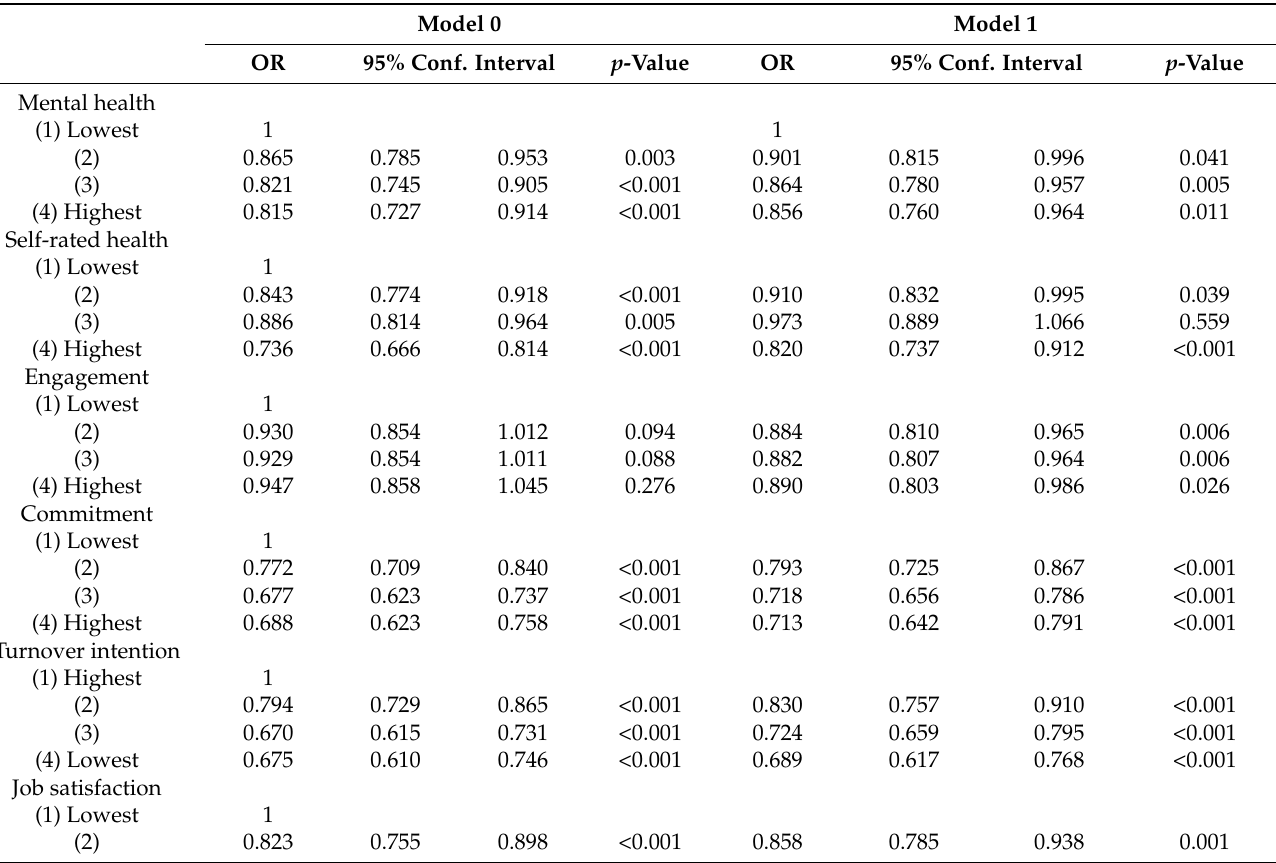
Table 3. Associations of the quartiles of the seven most distinctive factors for ECFs with employees’ health and job attitudes. Model